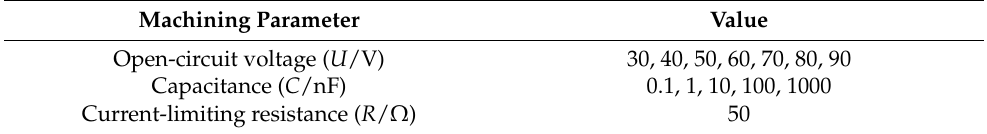
Table 1. Main discharge